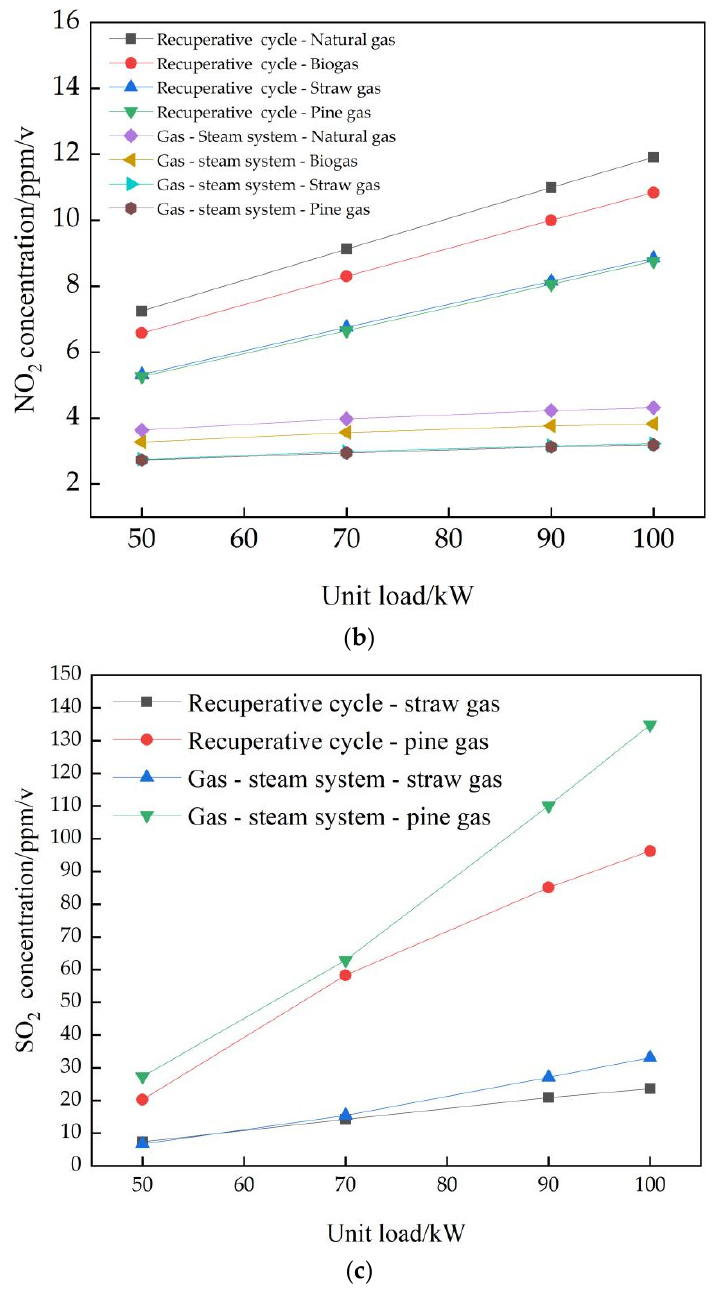
Figure 7. NOx and SO 2 emissions of combined cycle systems at different loads. ( a ) NO emissions of combined cycle systems at different load cases; ( b ) NO 2 emissions of combined cycle systems at different load cases; ( c ) SO 2 emissions of combined cycle systems at different load cases.